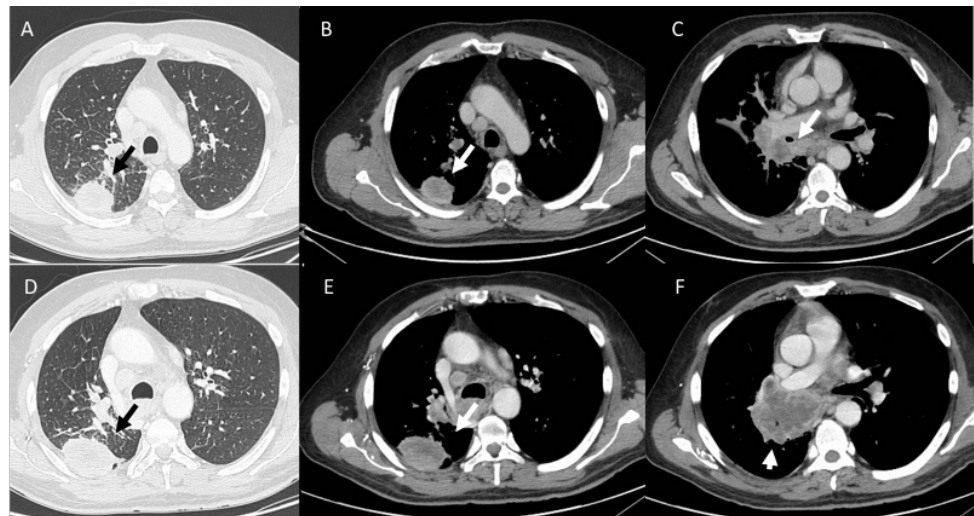
Figure 3. Pseudoprogression of brain metastasis (arrows) in an NSLC patient treated with immuno- therapy. CT evaluation ( A ) in pre-treatment phase, after 1 month ( B ), and after 12 weeks of the first CT evaluation ( C ).